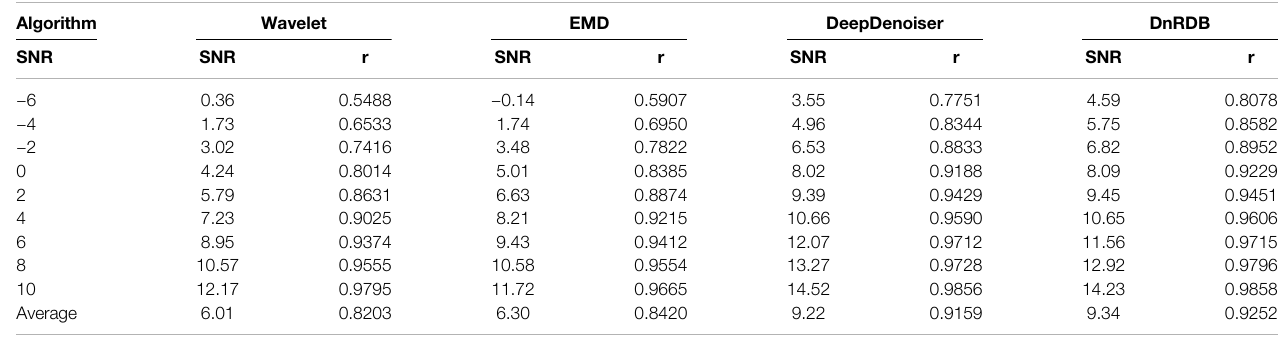
TABLE 2 | Comparison of the denoising effects of different algorithms for different